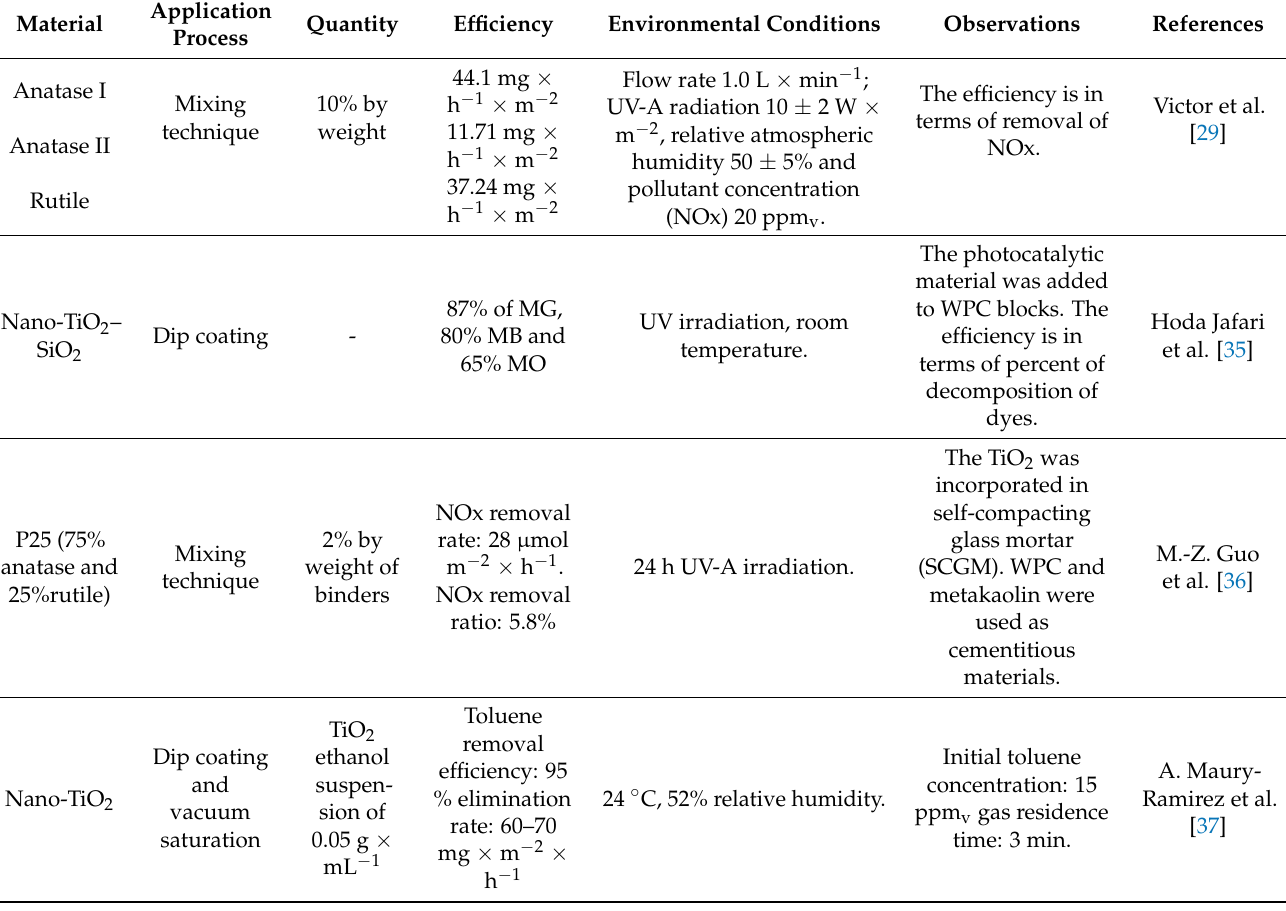
Table 2. Photocatalytic efficiency of cementitious materials with titanium dioxide